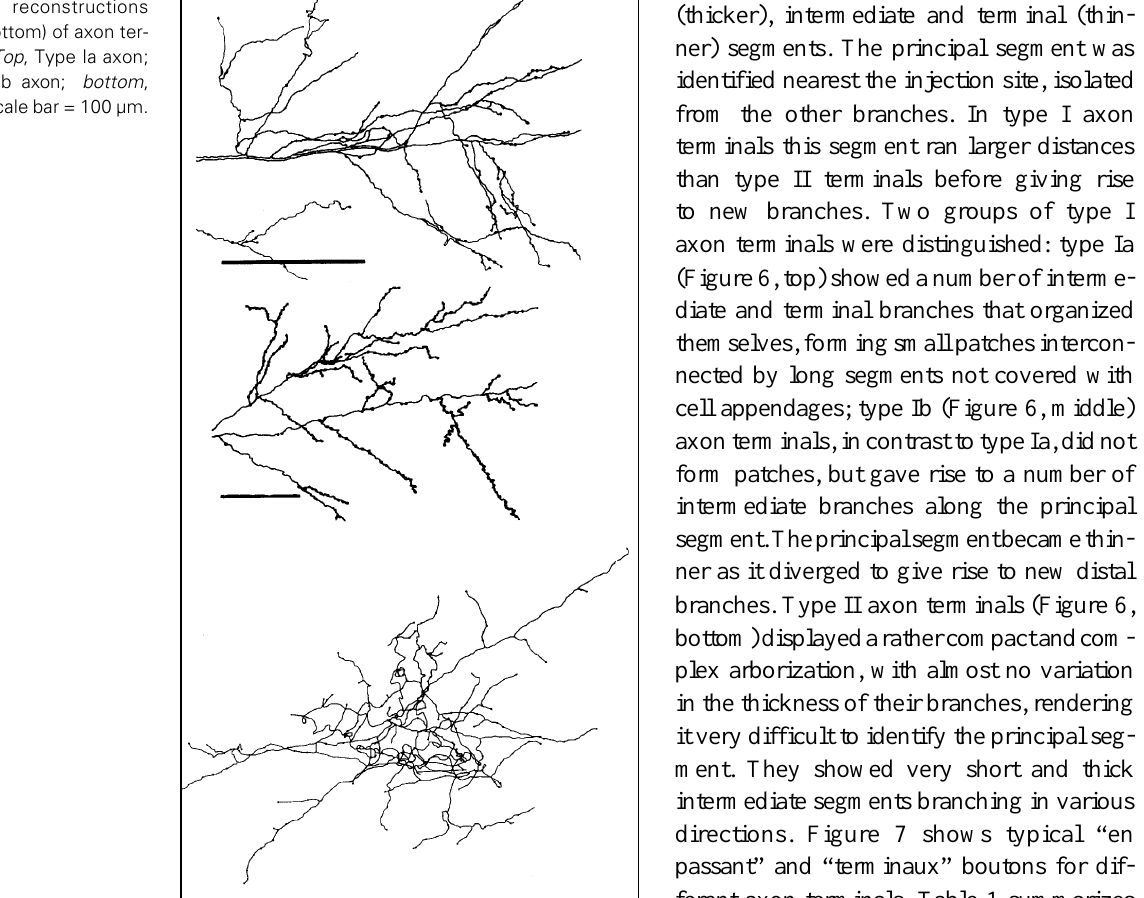
Figure 6 - Camera lucida drawing (top) and 3-D reconstructions (middle and bottom) of axon ter- minals in V1. Top , Type Ia axon; middle , type Ib axon; bottom , type II axon. Scale bar = 100